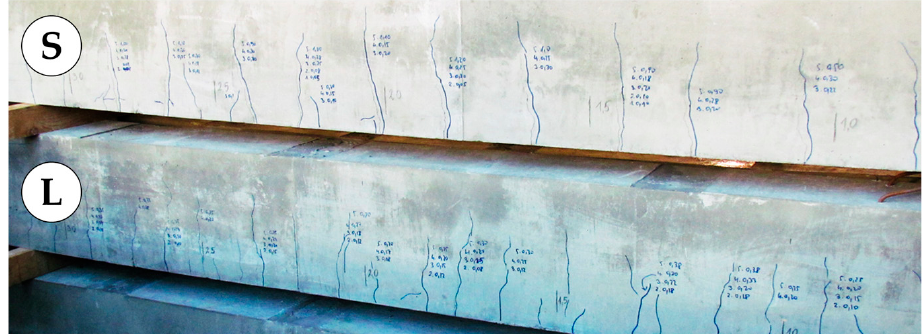
Figure 19. Documented crack width and spacings, for example, S- and L-type beam.